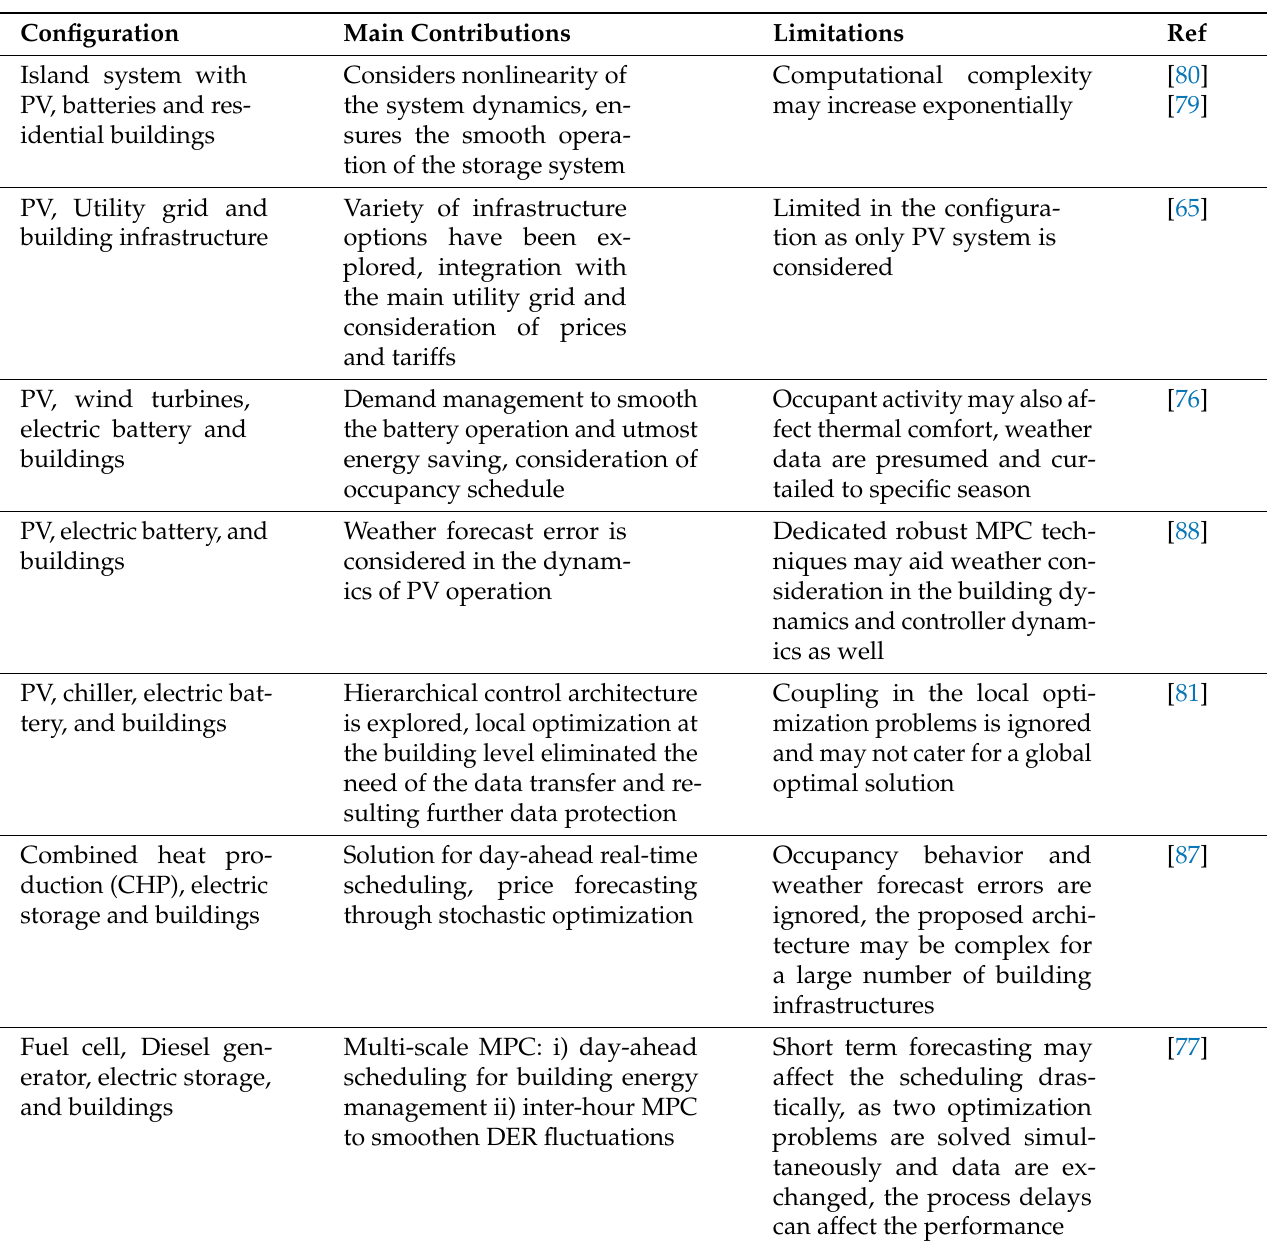
Table 2. MPC schemes applied to HVAC Buildings Comfort Systems integrated with